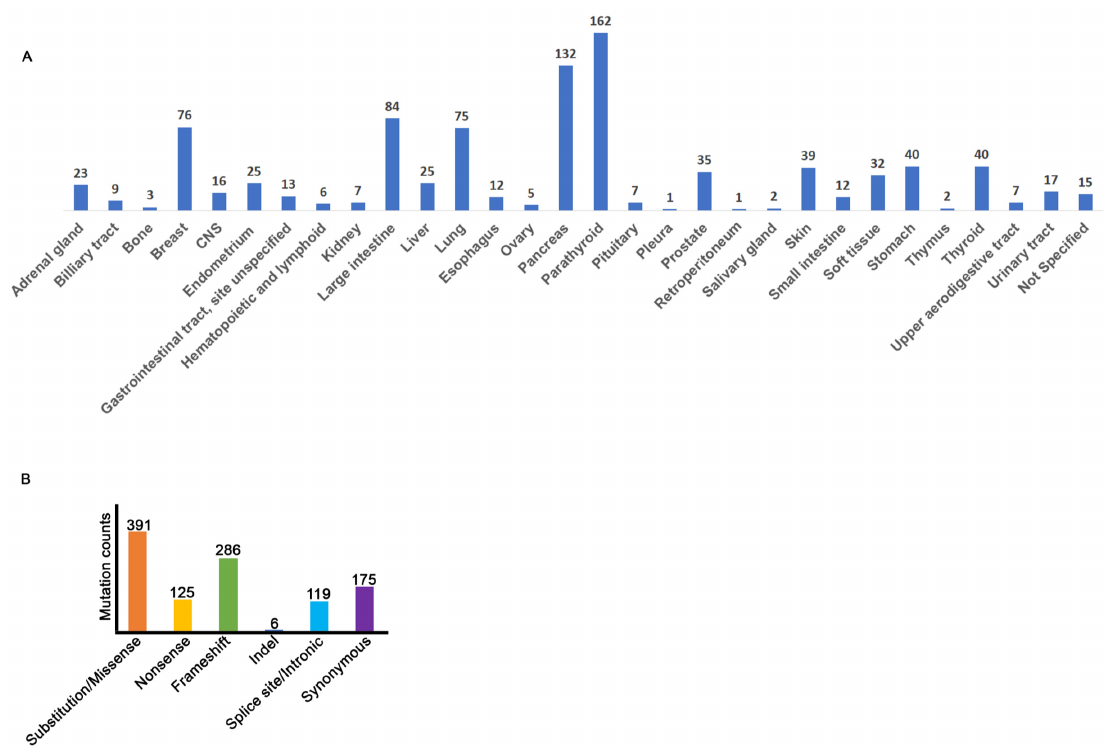
Figure 2. Tissue distribution of all MEN1 mutations reported on the Catalogue of Somatic Mutations in Cancer (COSMIC). ( A ) Frequency histogram of COSMIC mutations by tissue. ( B ) Distribution of COSMIC MEN1 mutations by mutation type. Splice site/intronic category also includes 5’ and 3’ untranslated regions (UTRs).